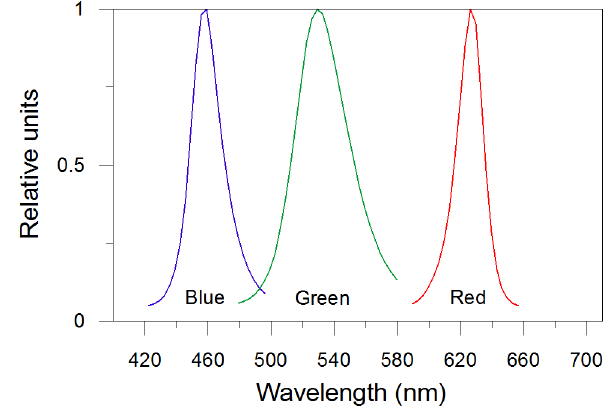
Figure 2. Spectral properties of the LEDs. Blue (422 2 496 nm), green (480 2 580 nm) and red light (590 2 656